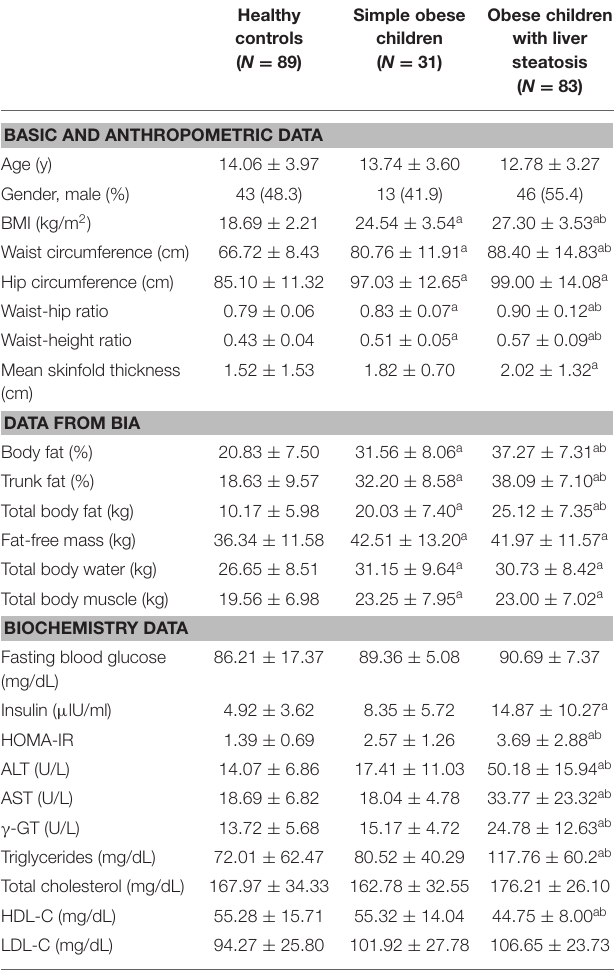
TABLE 1 | Comparison of clinical and laboratory parameters in healthy controls, simple obese children, and obese children with liver steatosis. Simple obese Healthy controls